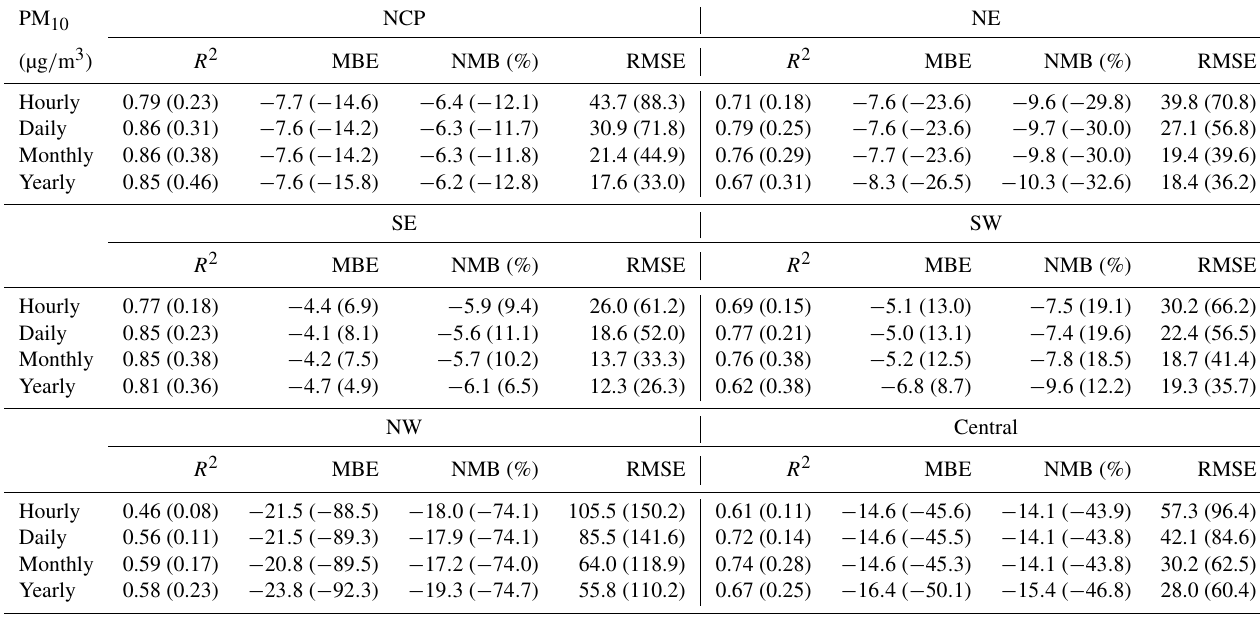
Table E2. CV results of the reanalysis (outside brackets) and base simulation (in brackets) for PM 10 concentrations in different regions of China on different temporal